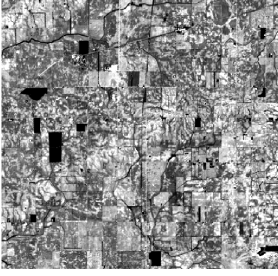
( c ) Figure 9. Classification results of the population of Indiana ( a ), the simulated population of Georgia ( b ), the thermal band ( c ), and the break points using adaptive GIC for multi-peak data. 5.3. Multi-Dimensional Data To deal with multi-dimensional data, we transformed the RGB composite into a new feature space by calculating the Euclidean norm of each pixel. Figure 10 shows the feature map and the classification results using the adaptive GIC. This feature maintains the rep- resentative information of higher dimensions, i.e., the spectral domain, and reduce the